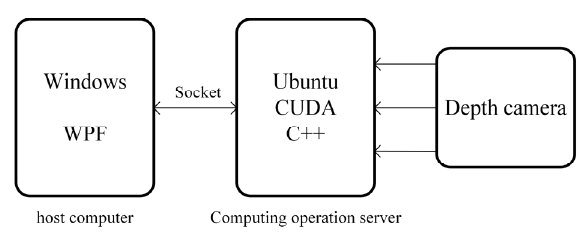
Figure 9. Hardware diagram of the measurement system.